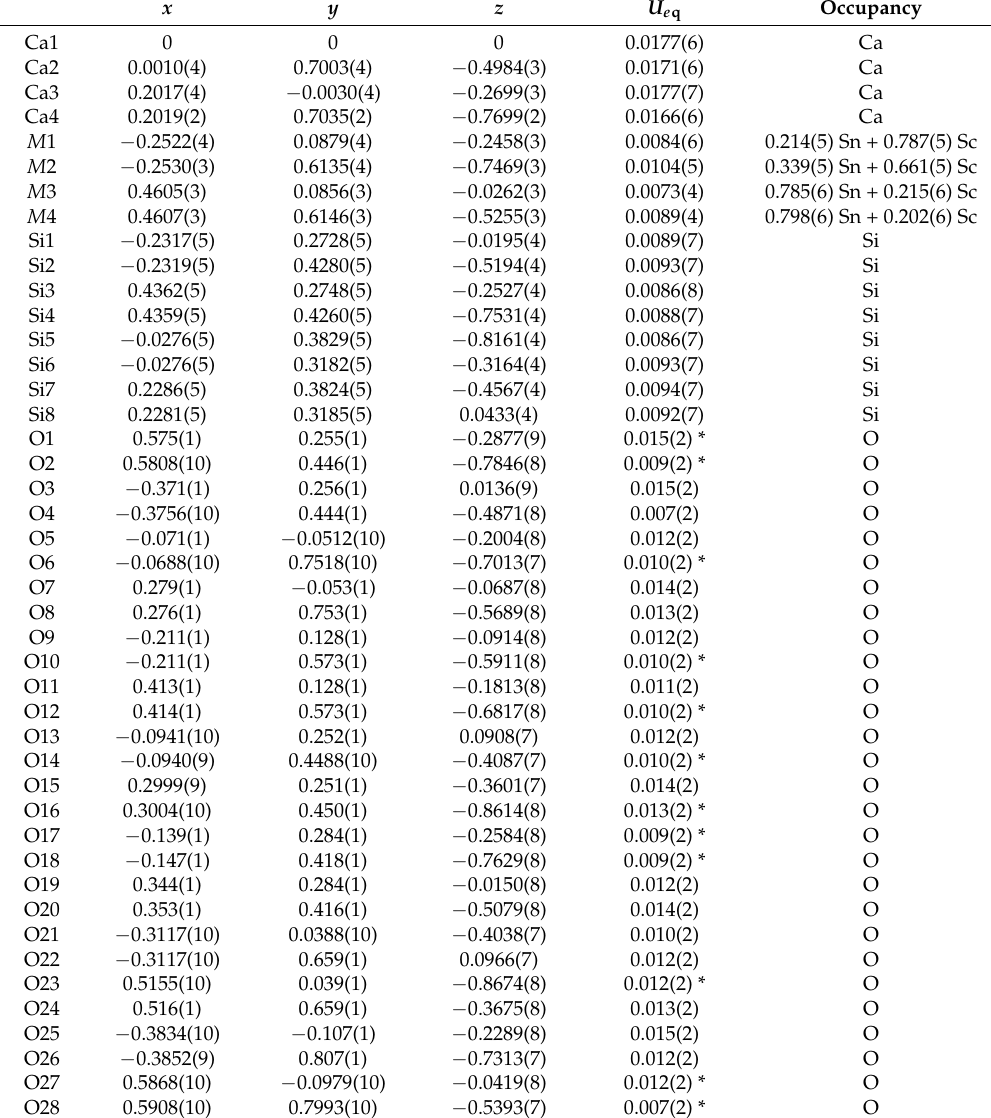
Table 3. Atomic coordinates, equivalent isotropic displacement parameters, and occupancy for atomic sites in kristiansenite (the occupancy for anion sites are from bond valence